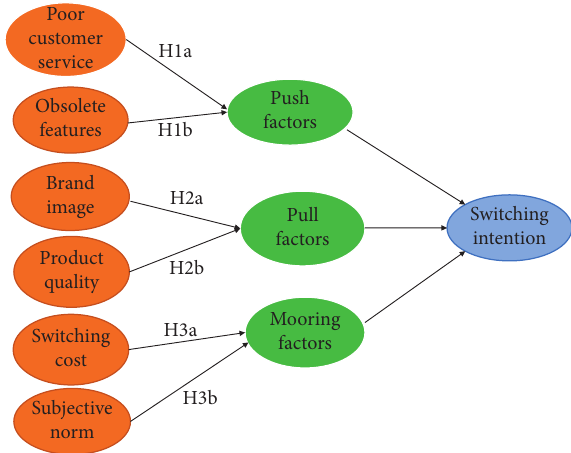
Figure 1: Conceptual structural equation model